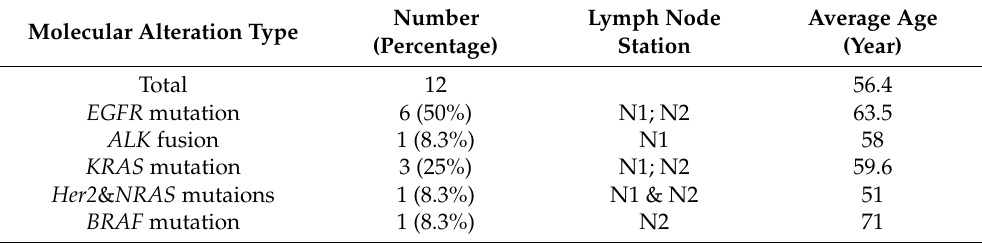
Table 3. Clinical characteristics in 12 patients with lymph node molecular alterations.